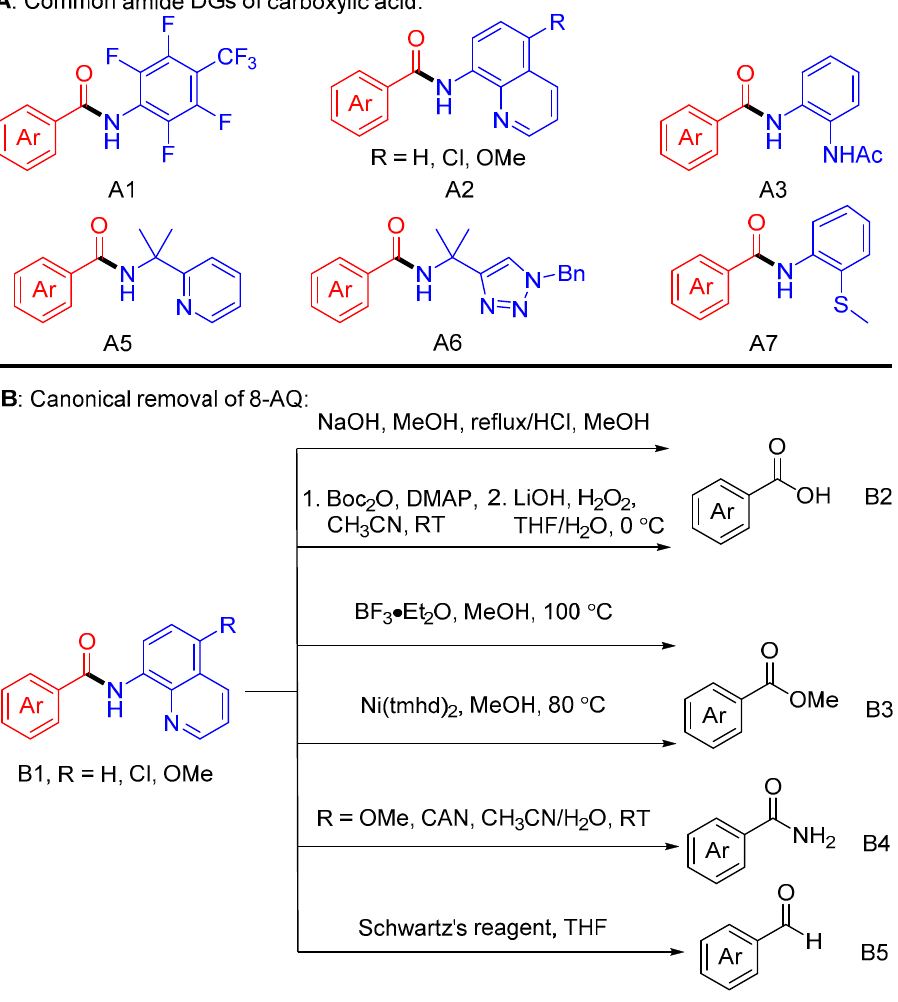
Figure 1. New strategy to remove 8-aminoquinoline